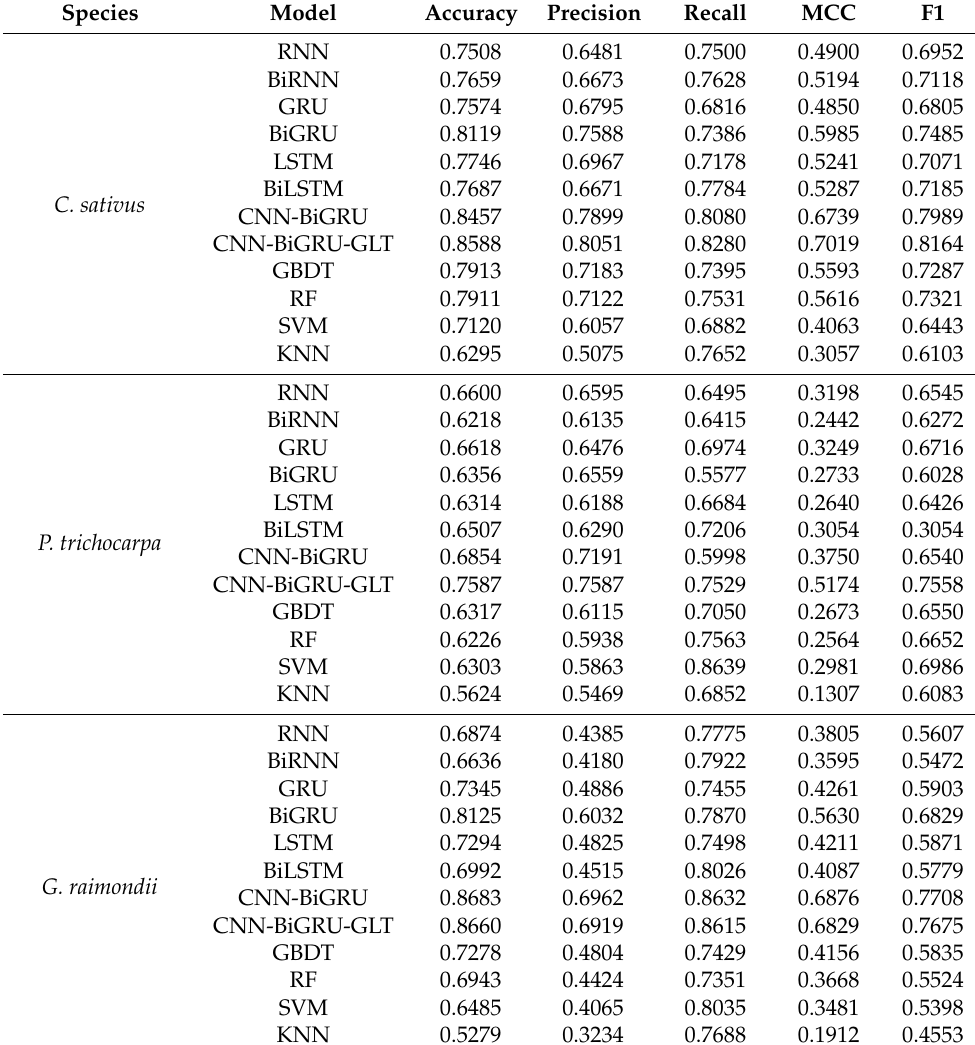
Table 8. Performance of the CNN-BiGRU-GLT model on three independent test sets and comparison results with aforementioned traditional machine learning and deep learning